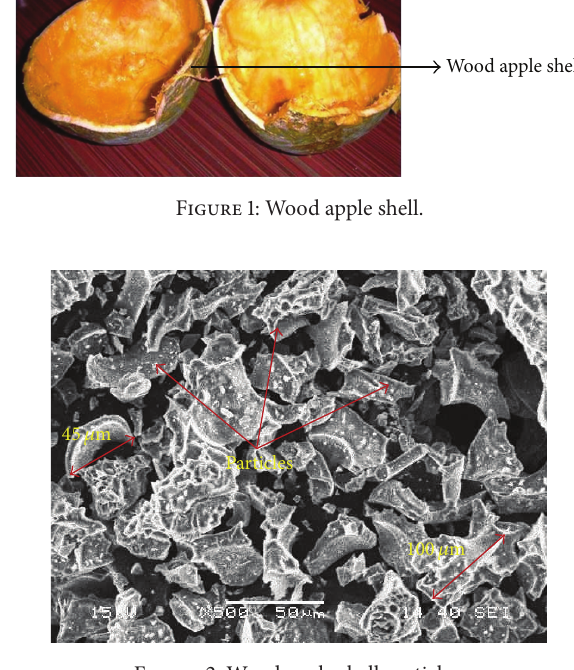
Figure 2: Wood apple shell particles. Table 1: Proximate analysis (% by mass) of wood apple shell